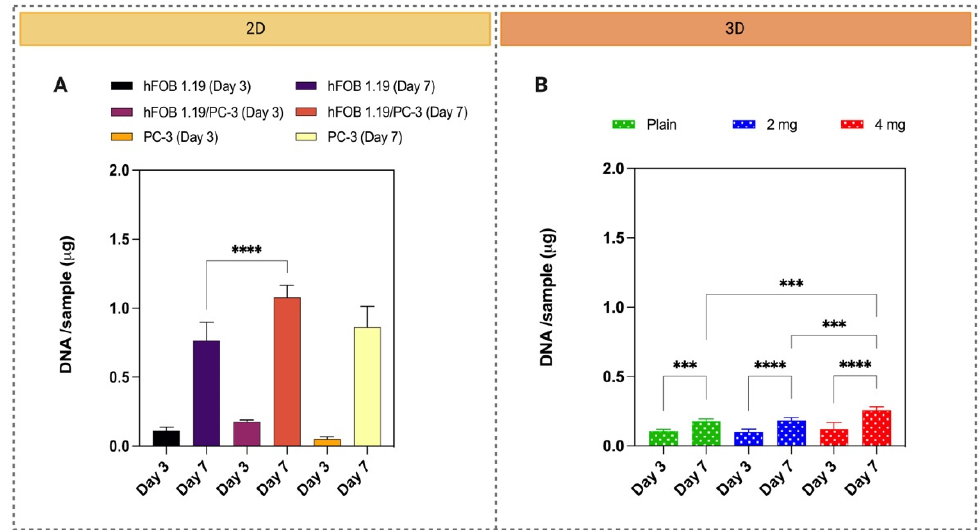
Figure 6. Quantification of cell viability (Quant-iT Picogreen) in ( A ) 2D mono- and co-cultures and ( B ) 3D co-cultures. ( B ) (green) PLGA scaffolds; (blue) 2 mg nHA/PLGA scaffolds; and (red) 4 mg nHA/PLGA scaffolds. The total DNA concentration/sample is expressed as the mean ± SD. The data represents 2 independent experiments and a total of n = 6 replicates per cell culture setup, day, and type of scaffold. *** p < 0.001, **** p < 0.0001.